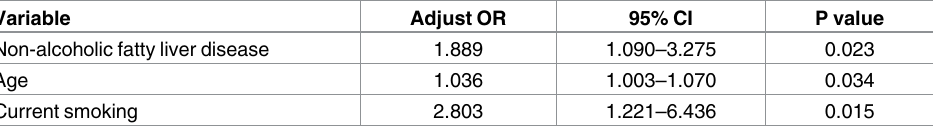
Table 3. Relationship of significant variables in female sexual dysfunction by multiple logistic regres- sion